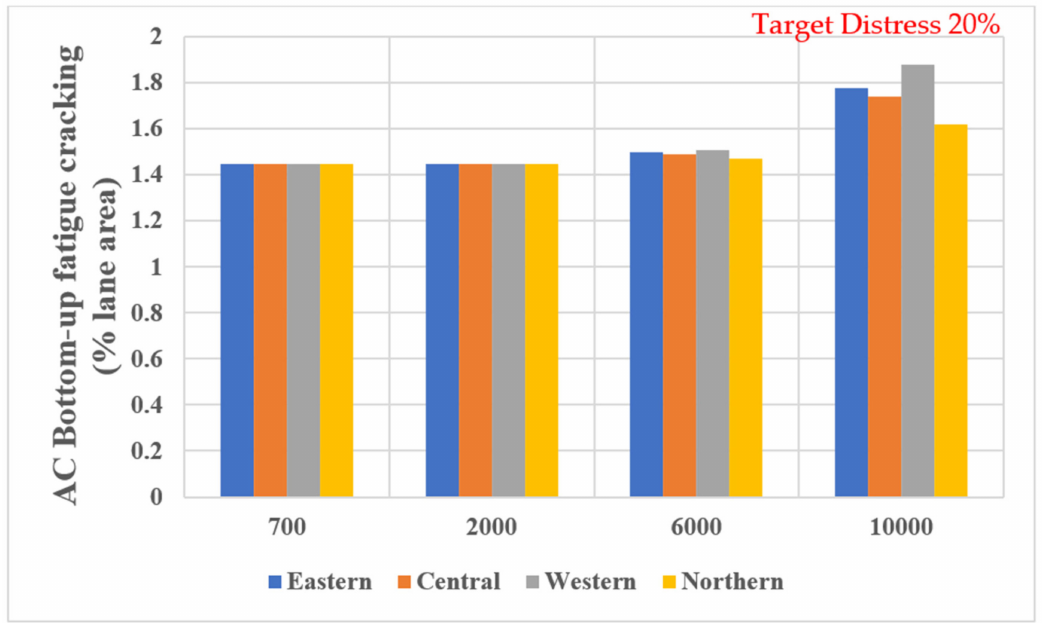
Figure 11. AC Bottom-up fatigue cracking (% lane area) for all different types of traffic for all the regions for 20 years design